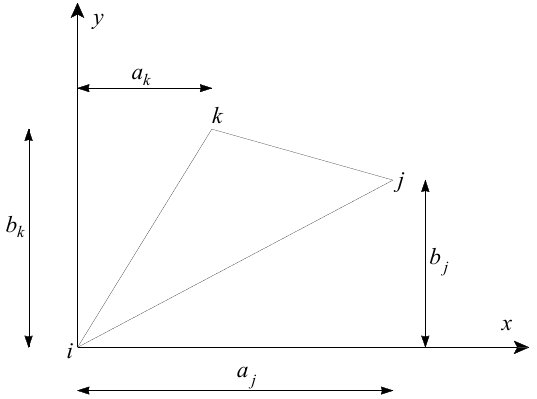
Figure 1. Triangular elements used in the generation of plate systems.